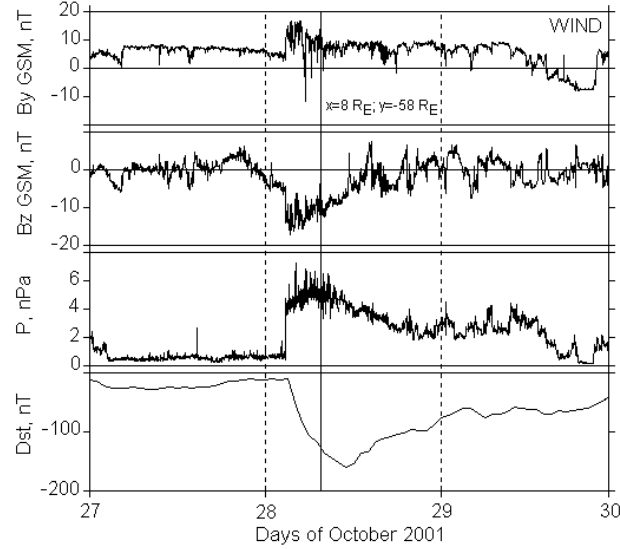
Fig. 1. IMF B y , B z and dynamic pressure measured by the Wind satellite and D st index for observations on 27 October–30 October 2001. The vertical line indicates the time of enhanced Pc1 activity in the polar